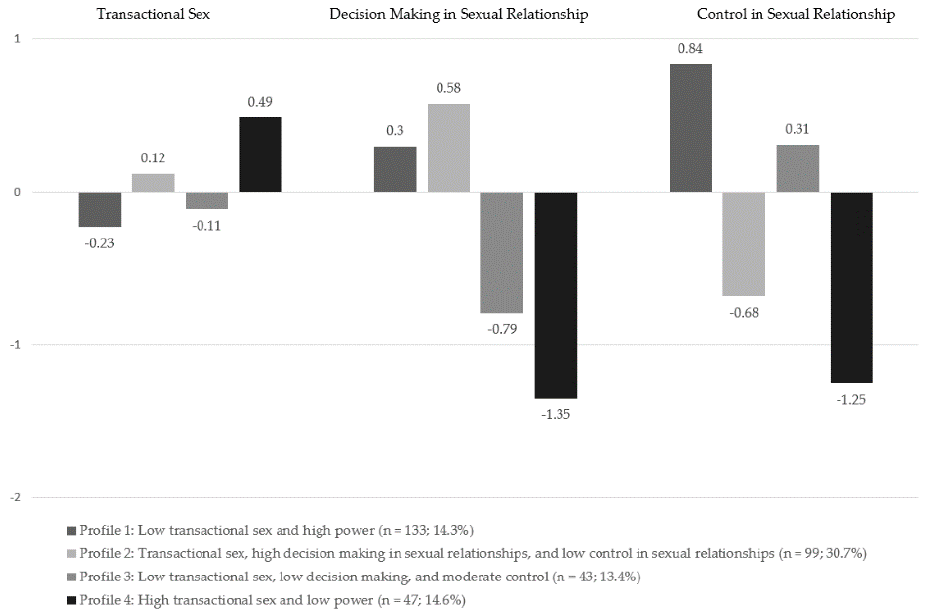
Figure 1. Sexual power profiles using standardized means.